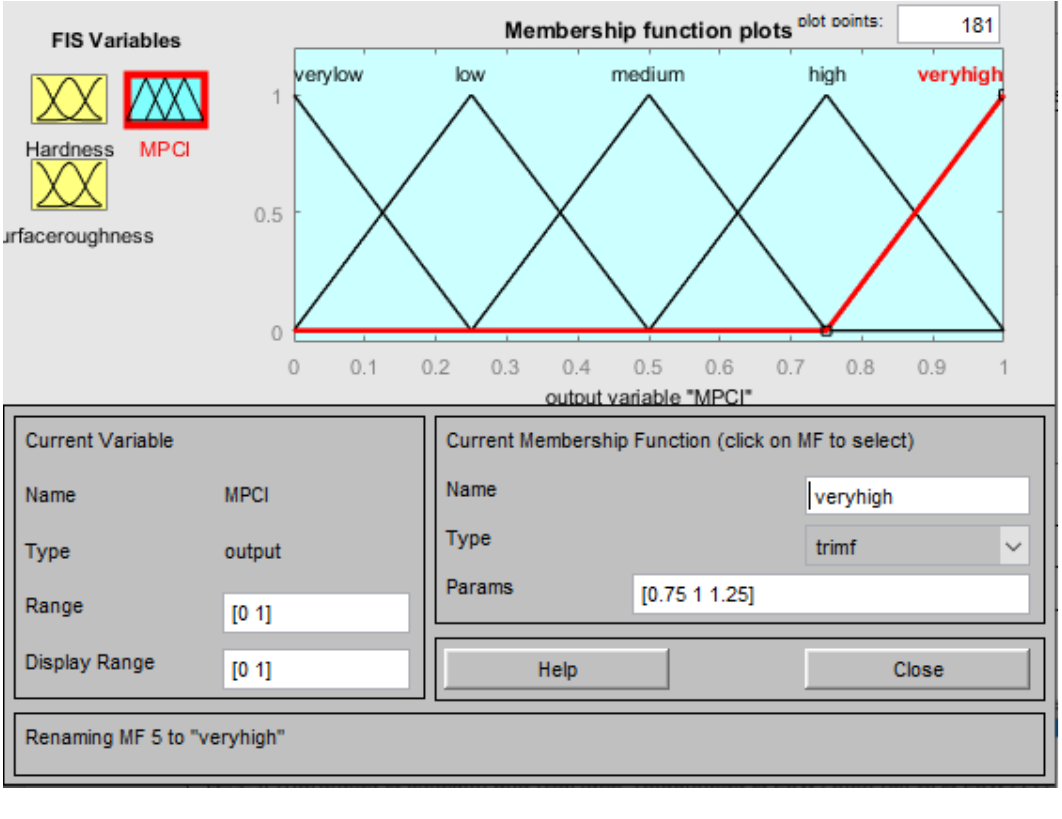
Figure 9. Membership function for the MPCI.